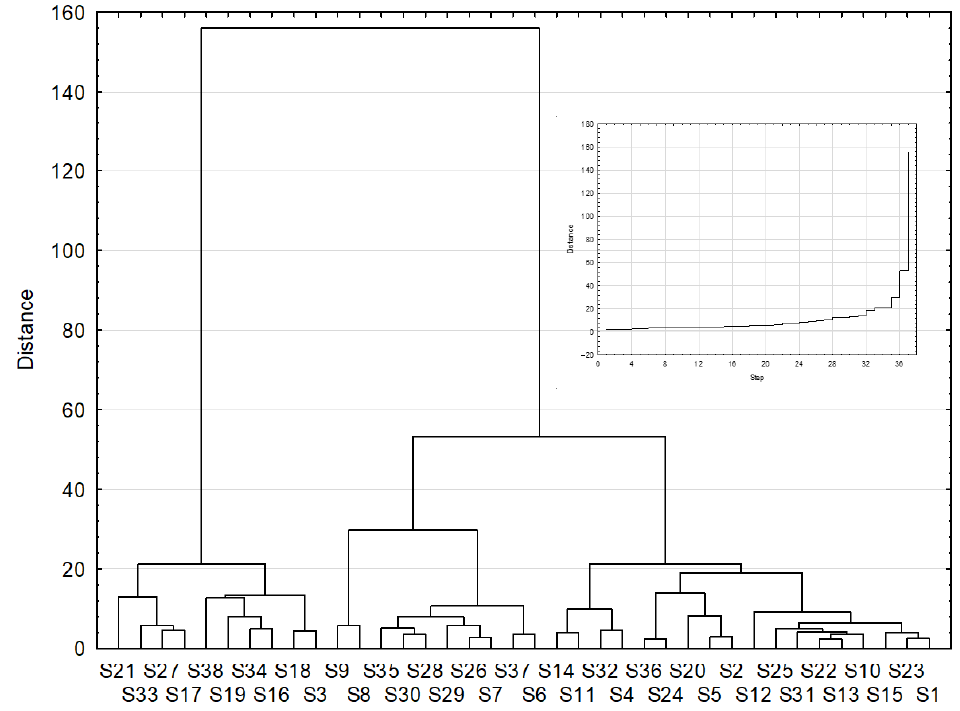
Figure 1. Hierarchical analysis with the process of agglomeration of fatty acid content in studied cheese n =